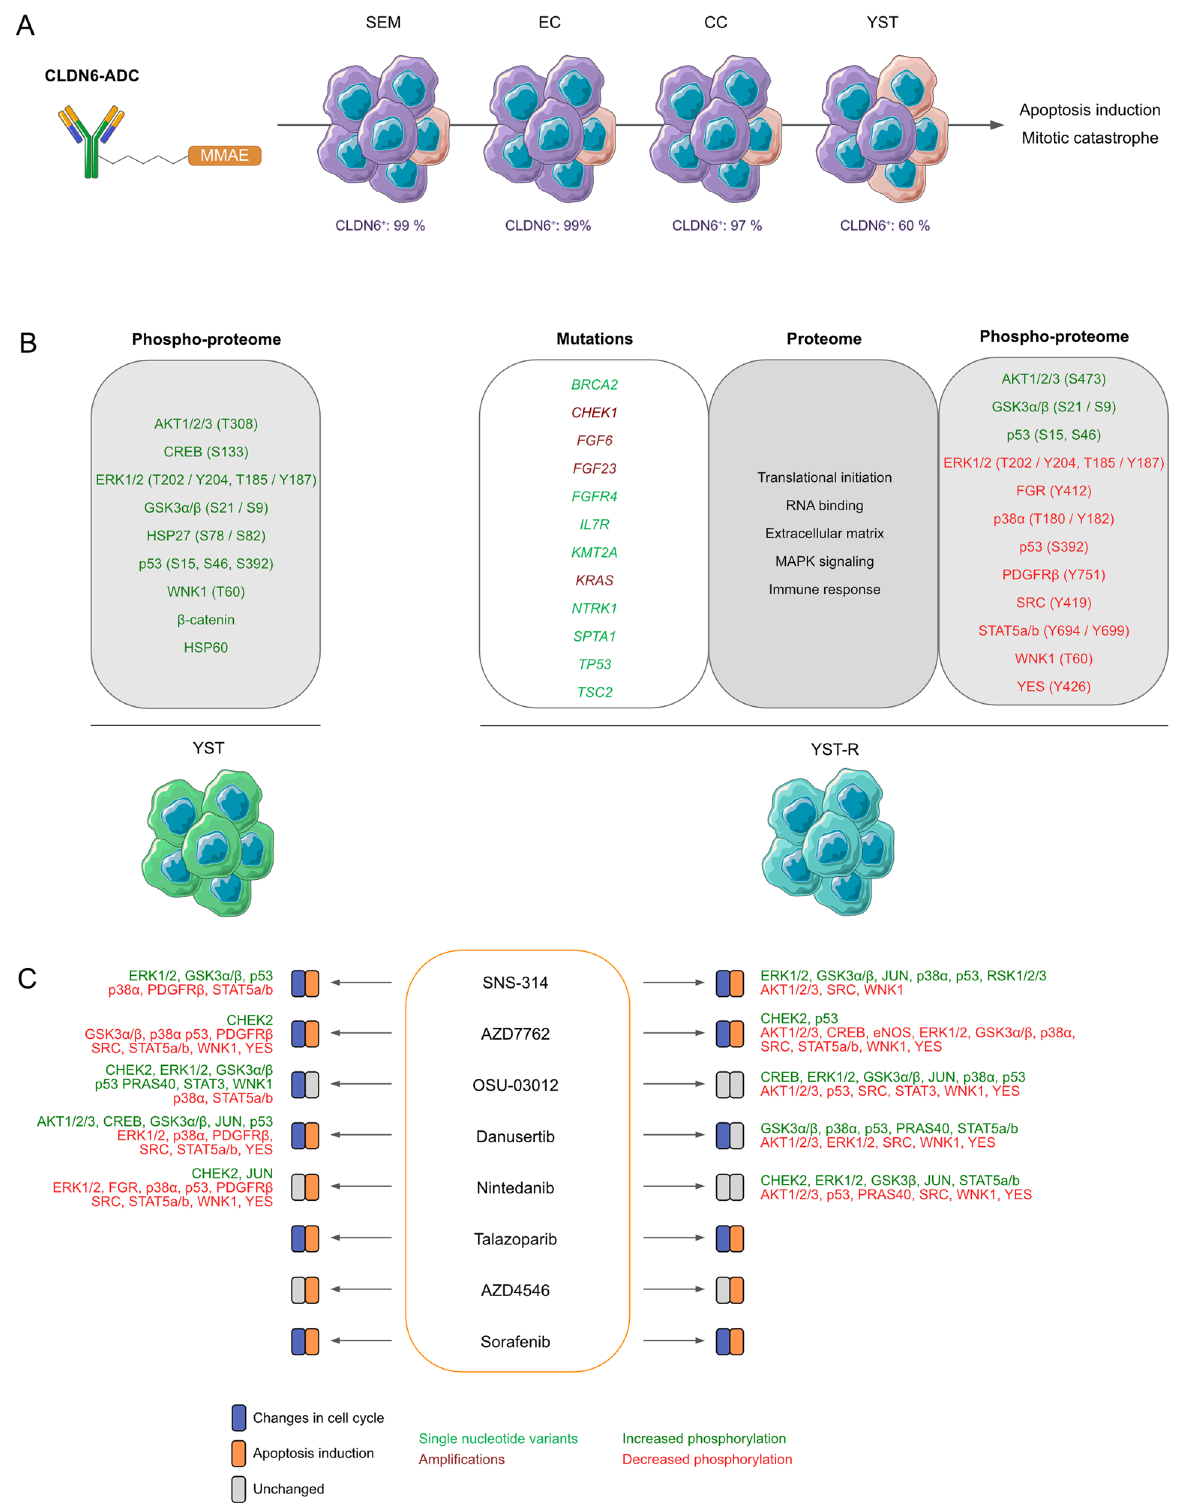
Fig. 5 Graphical summary of the observed findings of this study. A Targetability of GCT cells by the CLDN6‑ADC and provoked effects. B Molecular features of YST(‑R) cells on DNA and protein level. C Molecular effects of the drugs screened as therapeutic option for YST(‑R). Created using bioicons (https:// bioic ons.